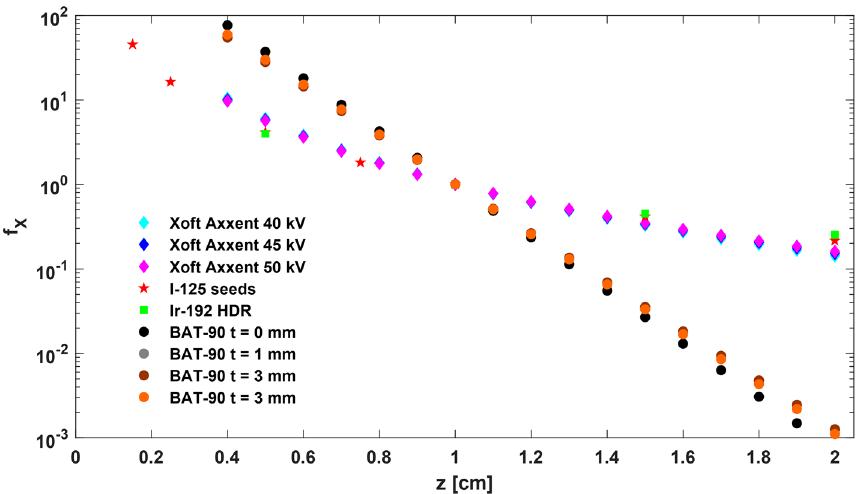
Figure 8. Dose fall-off f X of the source X along the transversal axis. It includes the absorption, the scatter and the geometrical distribution of the radioactive material. The sources considered are Xoft Axxent at 40 kV, 45 kV and 50 kV (light blue, blue and magenta diamond), I-125 seeds implants (red pentagram), Ir-192 HDR (green square) and BAT-90 with t = 0 mm, t = 1 mm, t = 3 mm and t = 5 mm (black, grey, brown and orange